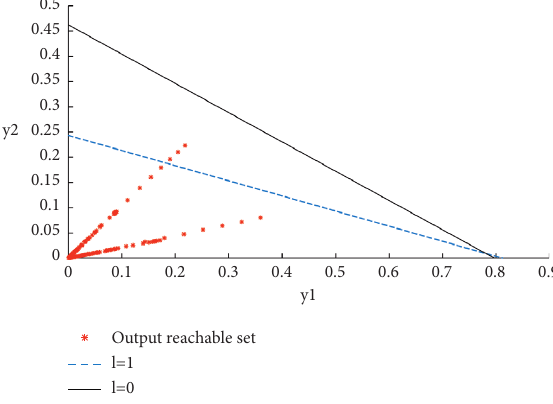
Figure 1: Estimation of output reachable set with ϑ ∈ Σ +